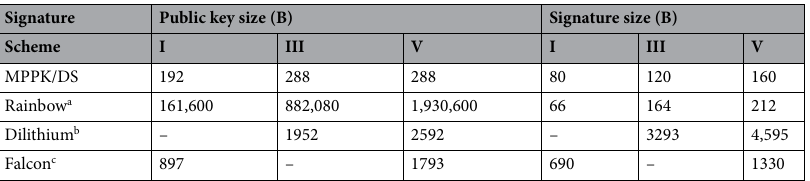
Table 3. Public Key and Signature sizes of the the MPPK/DS scheme as well as the NIST PQC Round 3 Finalists, with values given in Bytes corresponding to various NIST Security Levels. a The rainbow1aclassic363232 primitive was measured for Level I, rainbow3cclassic683248 for Level III, and rainbow5cclassic963664 for Level V. b Dilithium does not provide primitive for NIST Level I, dilithium3 was used for Level III, and dilithium5 for Level V. c For Falcon, falcon512dyn was measured for Level I, no primitive was measured for Level III, falcon1024dyn was measured for Level V.